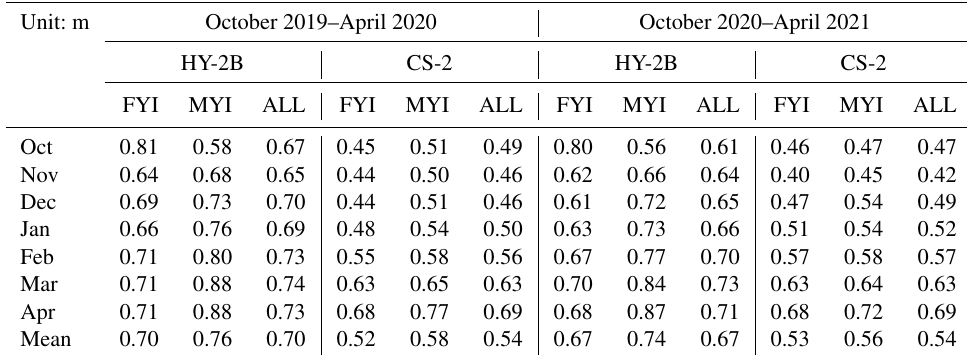
Table 10. Mean sea ice thickness uncertainties of HY-2B and CryoSat-2 on FYI, MYI and total sea ice. Unit: